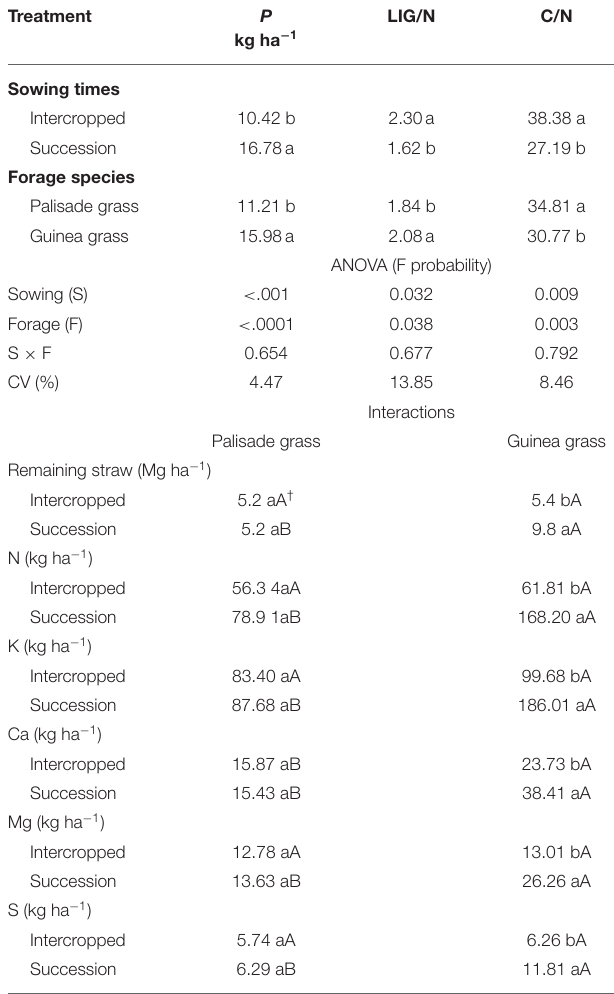
TABLE 3 | Remaining straw production, nutrient content, lignin/N (LIG/N) and C/N ratio in forage species sown at different times over two growing seasons.